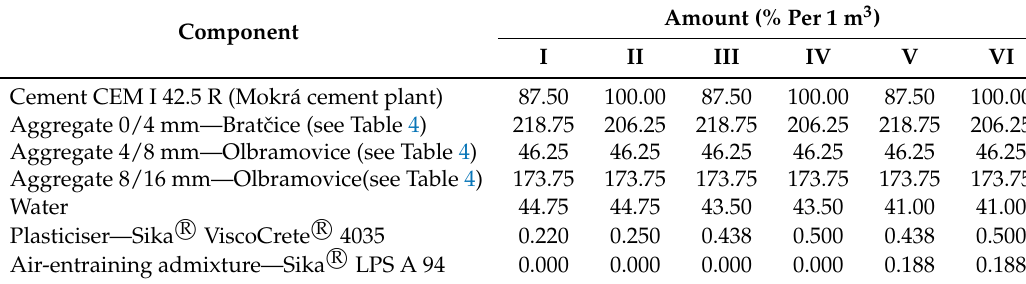
Table 7. Composition of the concretes.